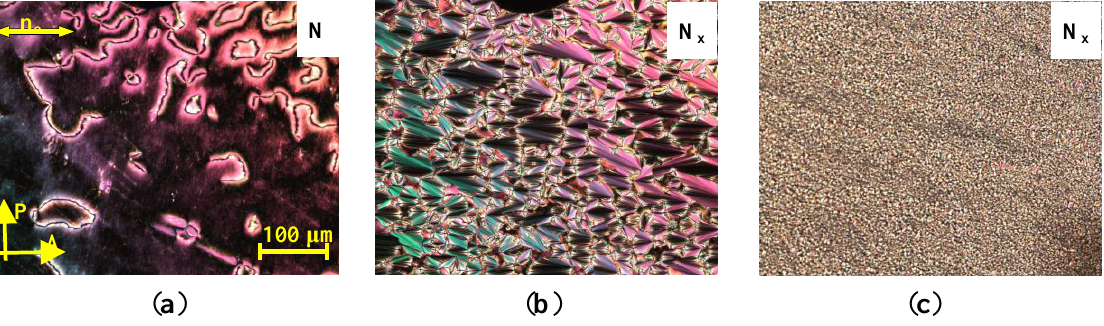
Figure 10. Textures of the MGTP208 (15% (w/w) 2 in 85% (w/w) CB_C9_CB ) between untreated glass slides, observed in the same region upon cooling between crossed polarizers: ( a ) schlieren texture in the high-temperature nematic N phase at 100 °C; ( b ) fan-like texture of the low-temperature N phase at 70 °C and ( c ) sheared texture of the x low-temperature N phase at 70 x